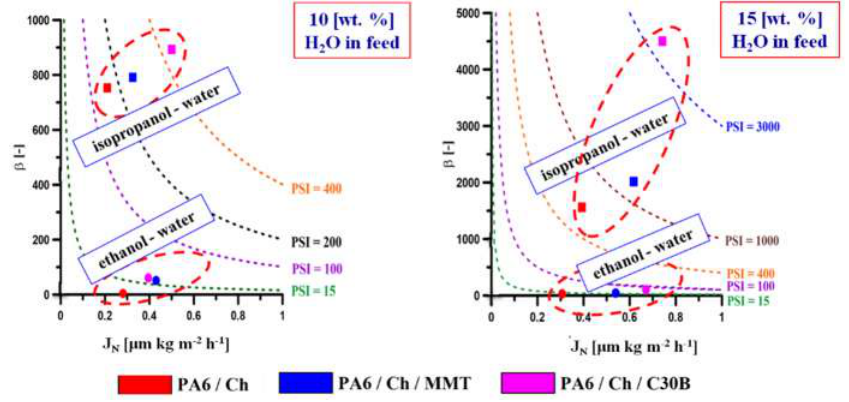
Figure 8. Comparison of various membranes’ performance during recovery of water from its binary alcohol mixtures.